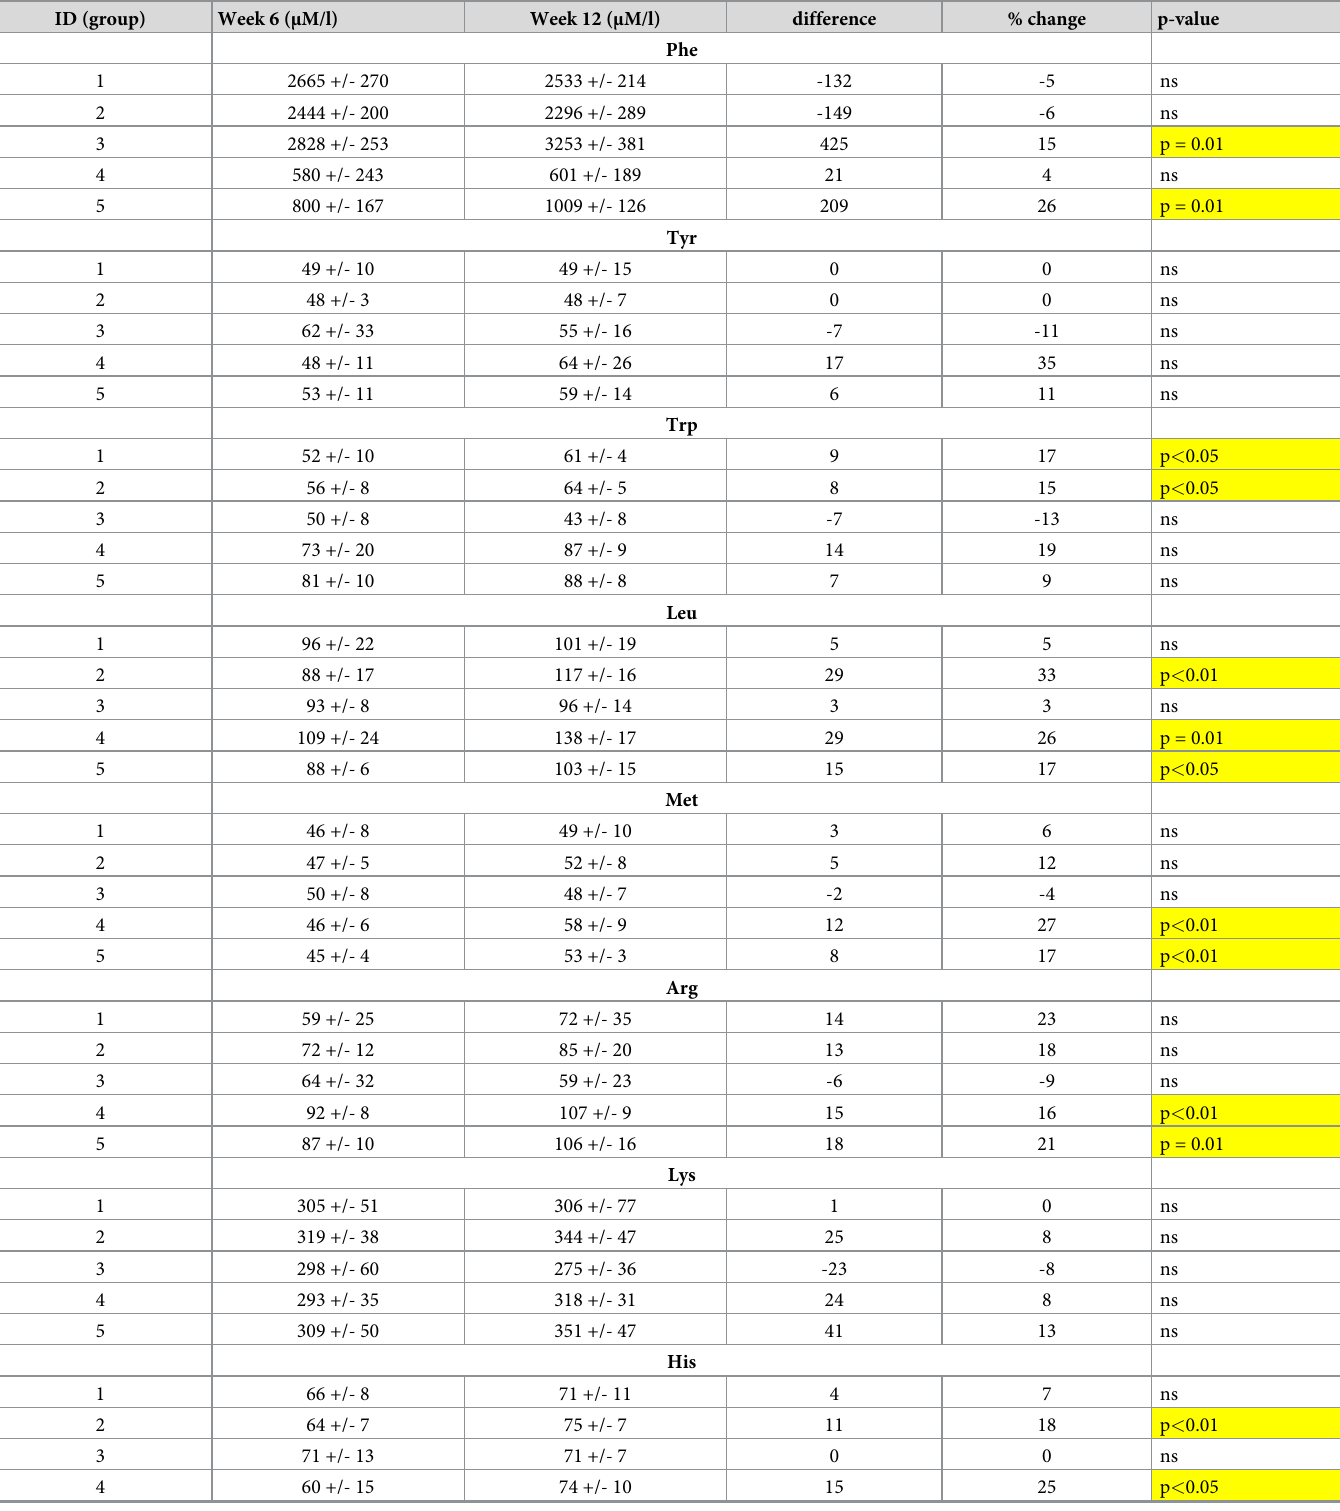
Table 4. Plasma content of selected AA in plasma measured at week 6 and 12 presented as mean and SD, difference from start to end and % change. ID